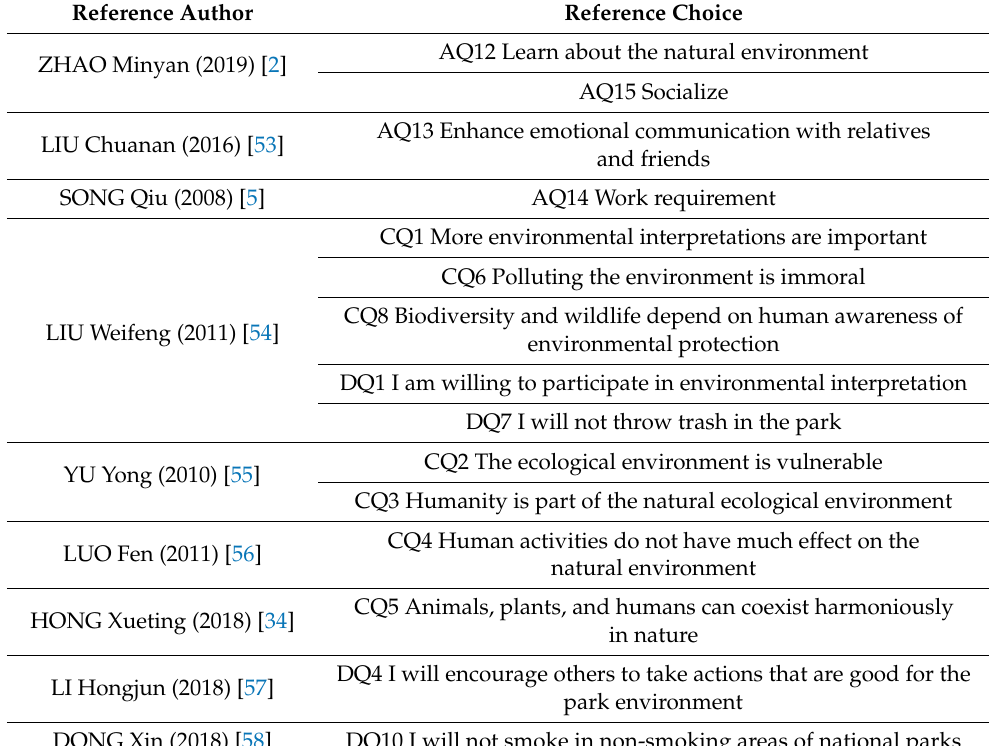
Table 1. Reference list for questionnaire